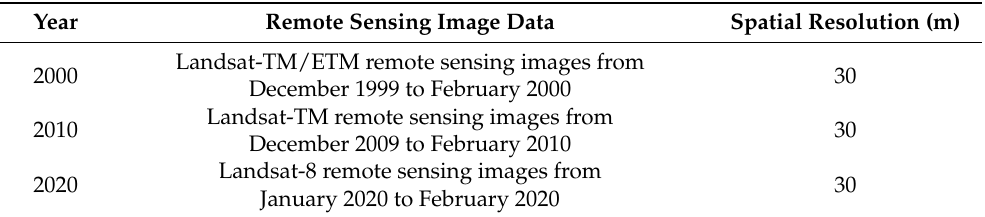
Table 1. Detailed Information of the Remote Sensing Images of Three Different Phases.